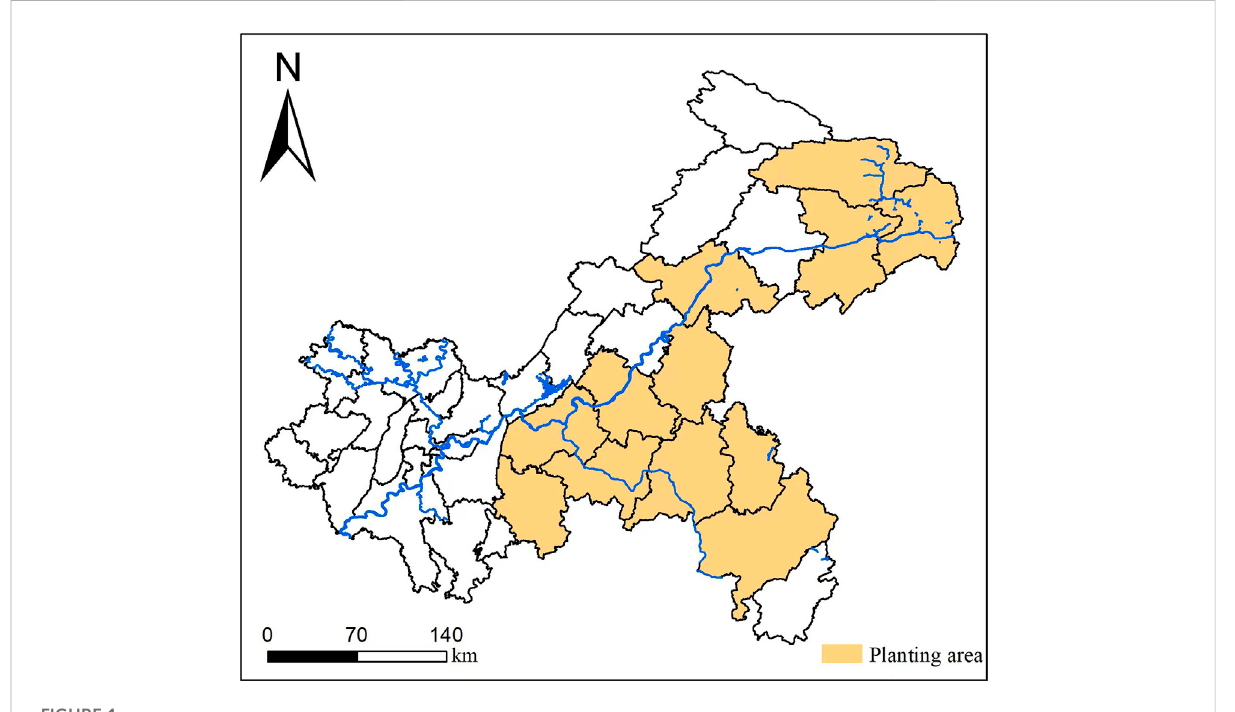
FIGURE 1 Distribution of tobacco production of Chongqing in